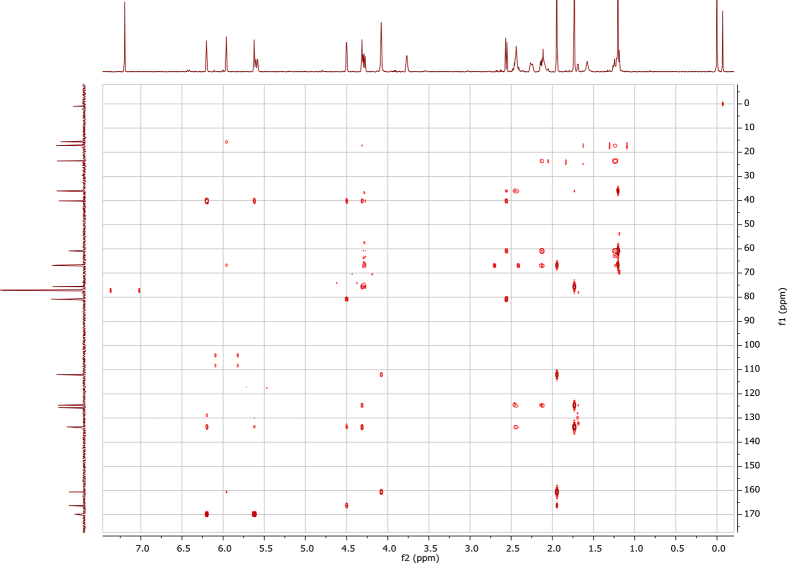
HMBC (CDCl3) spectrum of compound 5.